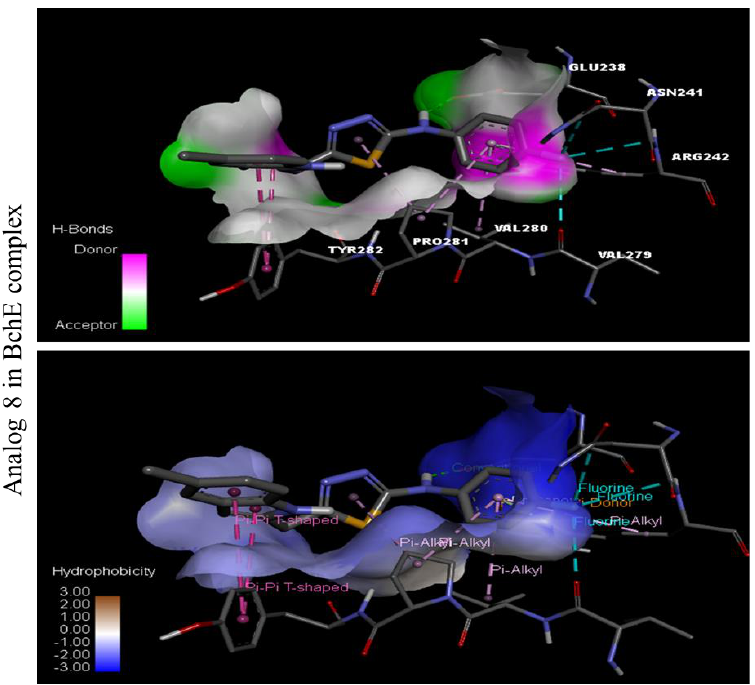
Figure 4. Indication of the hydrogen bond and hydrophobic nature against BuChE of compound 8.